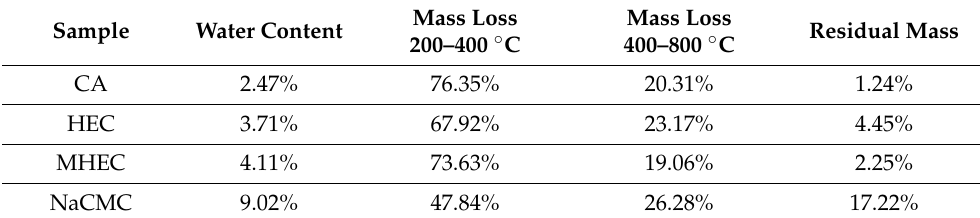
Table 4. Main thermal characteristics of the used cellulose